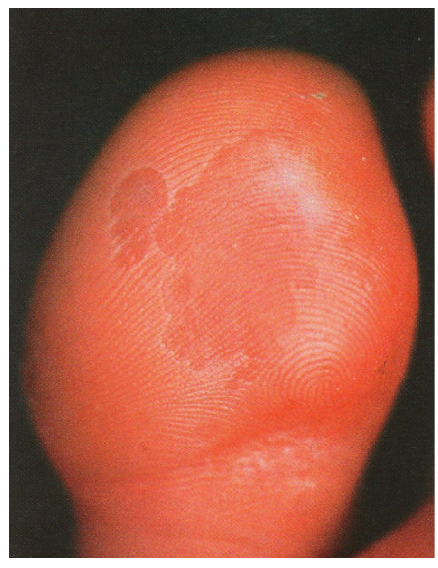
Figure 7: Pitted keratolysis [4, page